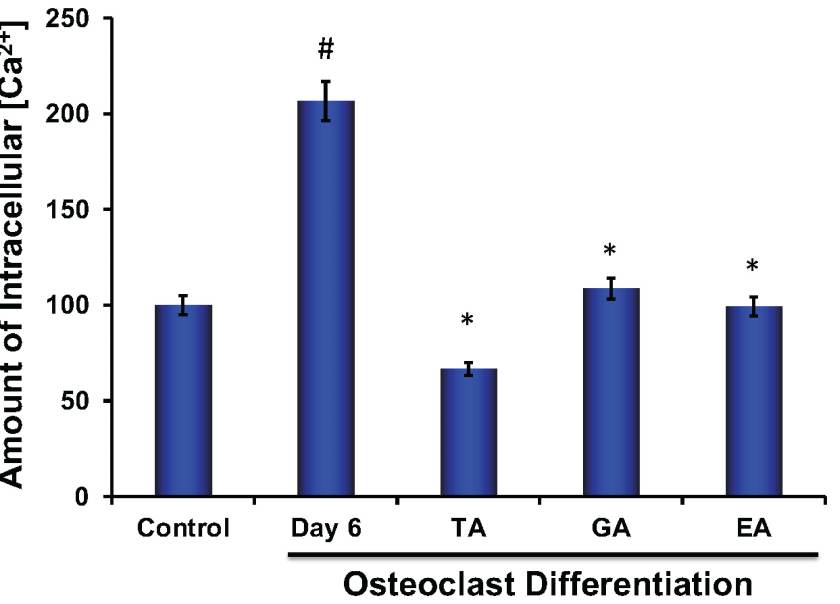
Figure 7. Polyphenolic compounds reduce intracellular Ca 2+ levels during osteoclast differentiation. Evaluation of intracellular Ca 2+ level was shown graphically at day 6 in the absence or presence of tannic acid (TA), gallic acid (GA), or ellagic acid (EA) during osteoclast differentiation. (# indicates p < 0.05 when compared between control and day 6 of osteoclast differentiated samples, * indicates p < 0.05, when compared between day 6 of osteoclast differentiated samples in the absence or presence of either of the polyphenolic